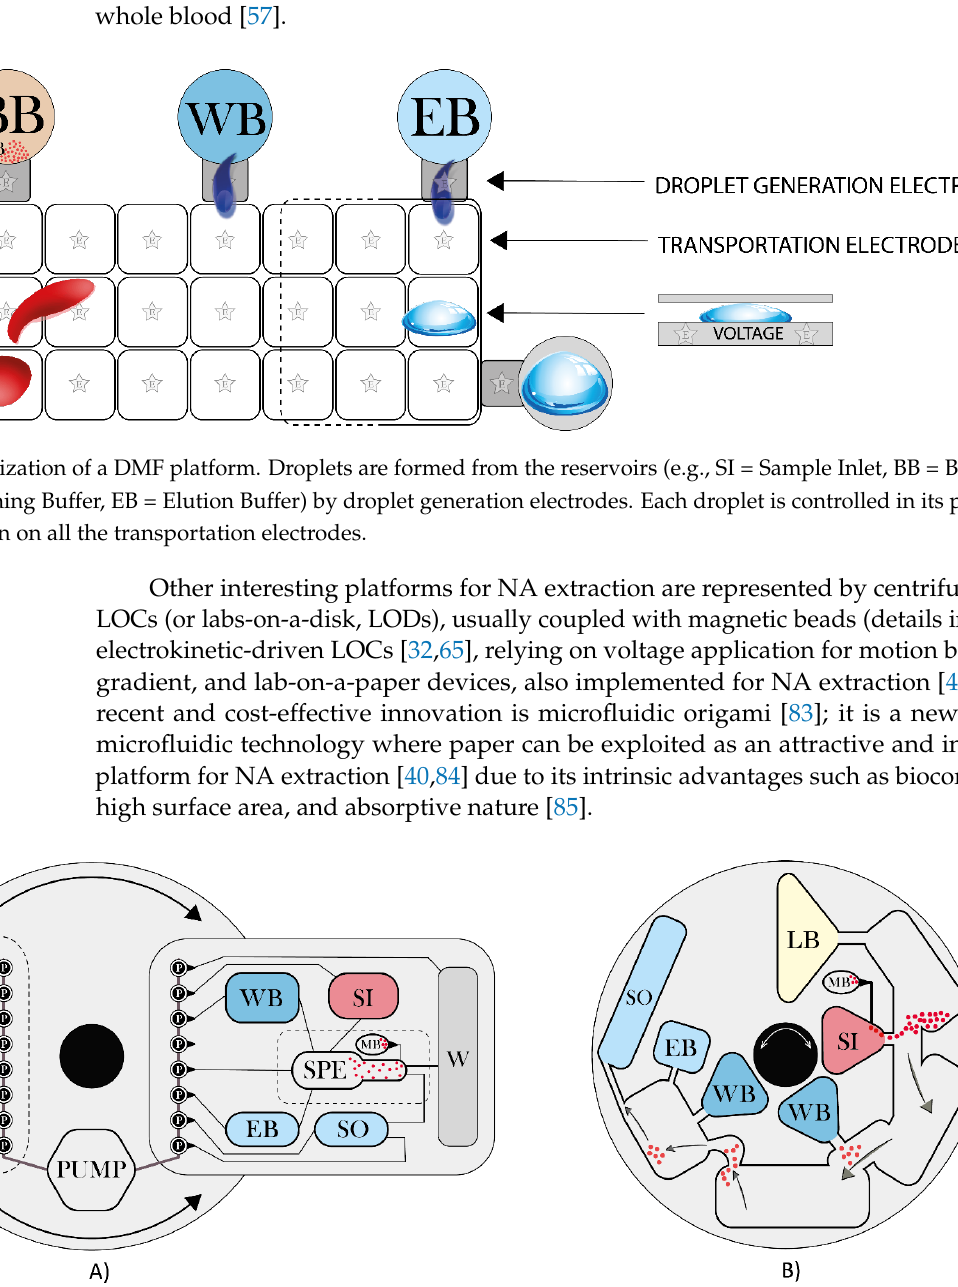
Figure 4. Schematization of ( A ) centrifugal and ( B ) lab-on-a-disk microfluidic systems. Both types, mostly based on a magnetic beads extraction or, less commonly, on silica filtration, are developed onto a rotating platform where sample and reagents motion is enabled by centrifugal and related forces (Coriolis and Euler) that, usually in combination with pneumatic forces, handle the fluidic system and enable sample processing. This principle is applied in traditional rectan- gular LOCs [36,71,86] and in LOD systems [18,41,51,53,54,60]. These devices generally manage the sample by changing speed and sense of rotation: a particular example of a LOD is represented by LabDisk analyzer [28,64] which implements an automated lyse-bind-wash-elute protocol by means of a gas-phase transition magnetophoresis principle, which com- bines magnetic and centrifugal forces to carry NA-complexed magnetic beads through the separation liquid/gas interfaces between each reaction chamber. P = pressure application with pump; SI = Sample inlet chamber; SPE = Solid-phase extrac- tion domain; MB = Magnetic beads chamber; LB = Lysis buffer reservoir; WB = Washing buffer reservoir; EB = Elution buffer reservoir; SO = Eluted sample outlet; W = Waste chamber.